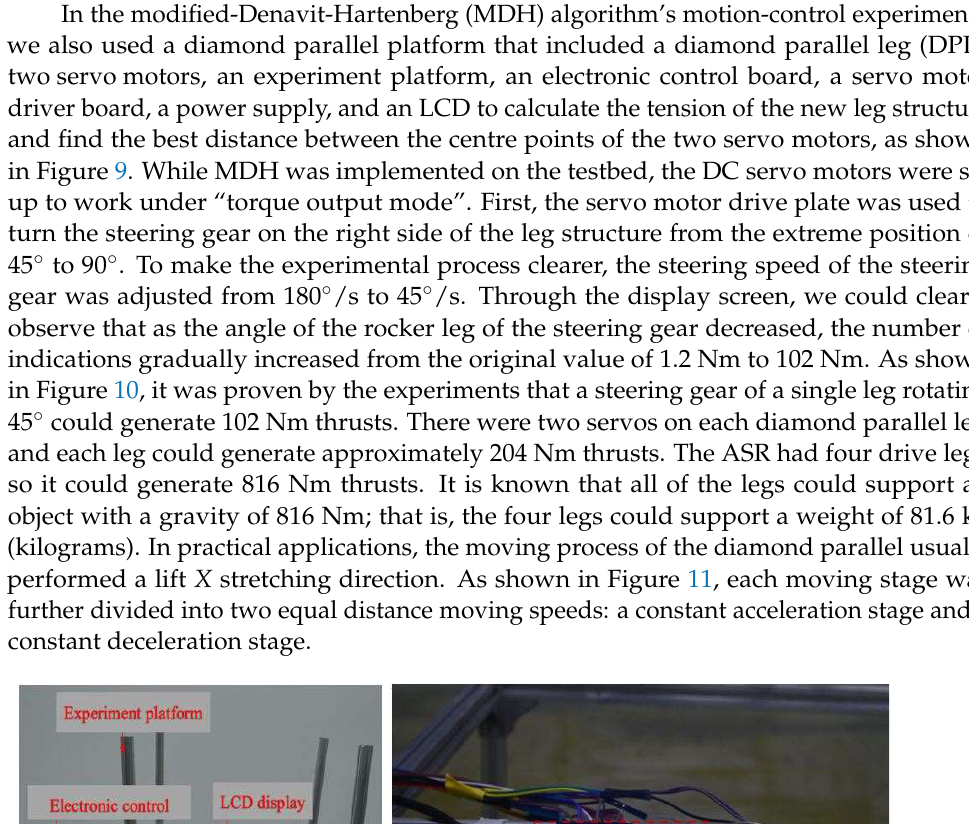
Figure 8. The propulsive force of the different power.